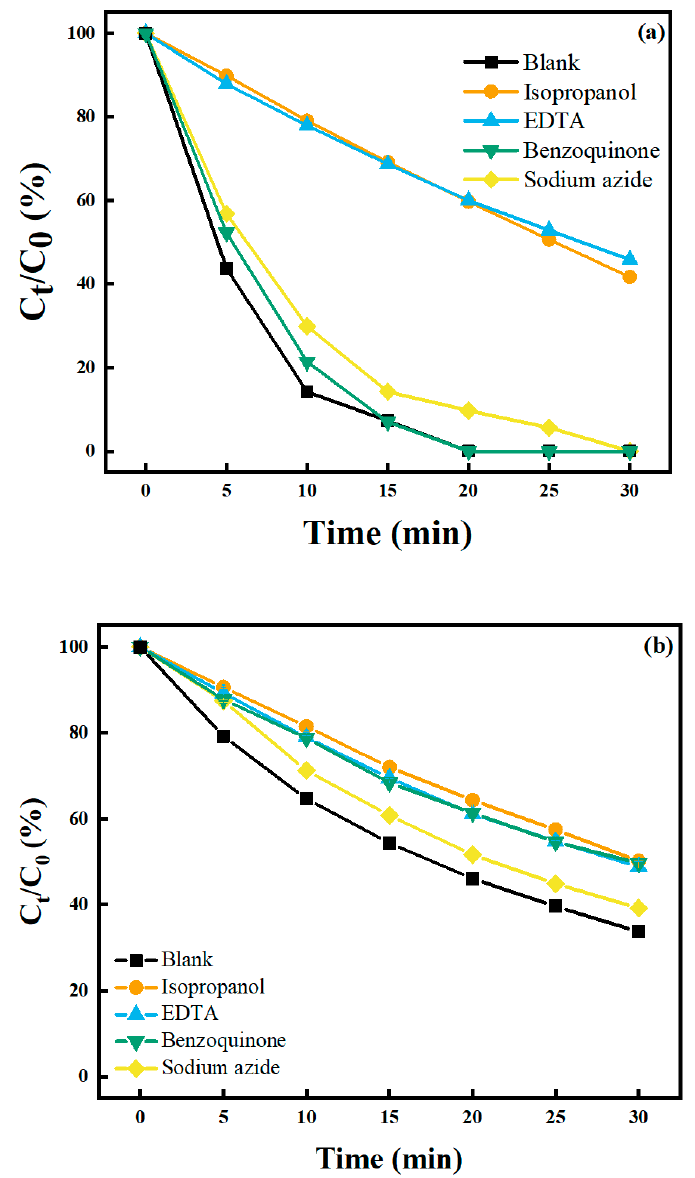
Figure 14. E ff ects of di ff erent quenchers for the photodegradation of MNZ under simulated sunlight Figure 14. Effects of different quenchers for the photodegradation of MNZ under simulated sunlight irradiation with ( a ) Ag / ZnO (100:1) and ( b ) AgI / ZnO (X = irradiation with ( a ) Ag/ZnO (100:1) and ( b ) AgI/ZnO (X = 0.4).